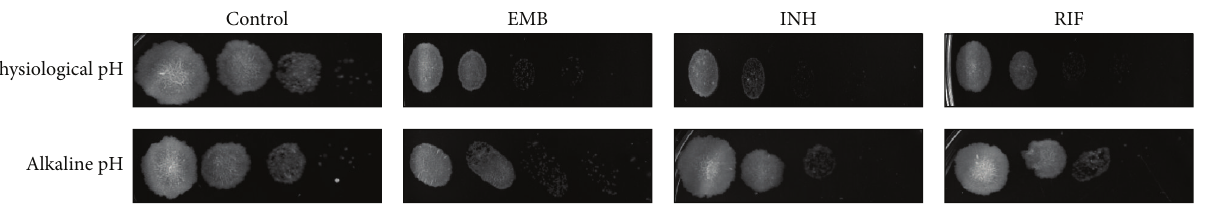
Figure 8: Drug susceptibility assay under alkaline pH. Spot assay of M. smegmatis in the absence and the presence of drugs EMB, INH, and RIF (62.5 ng/mL, 1 𝜇 g/mL, and 62.5 ng/mL) at physiological and alkaline pH